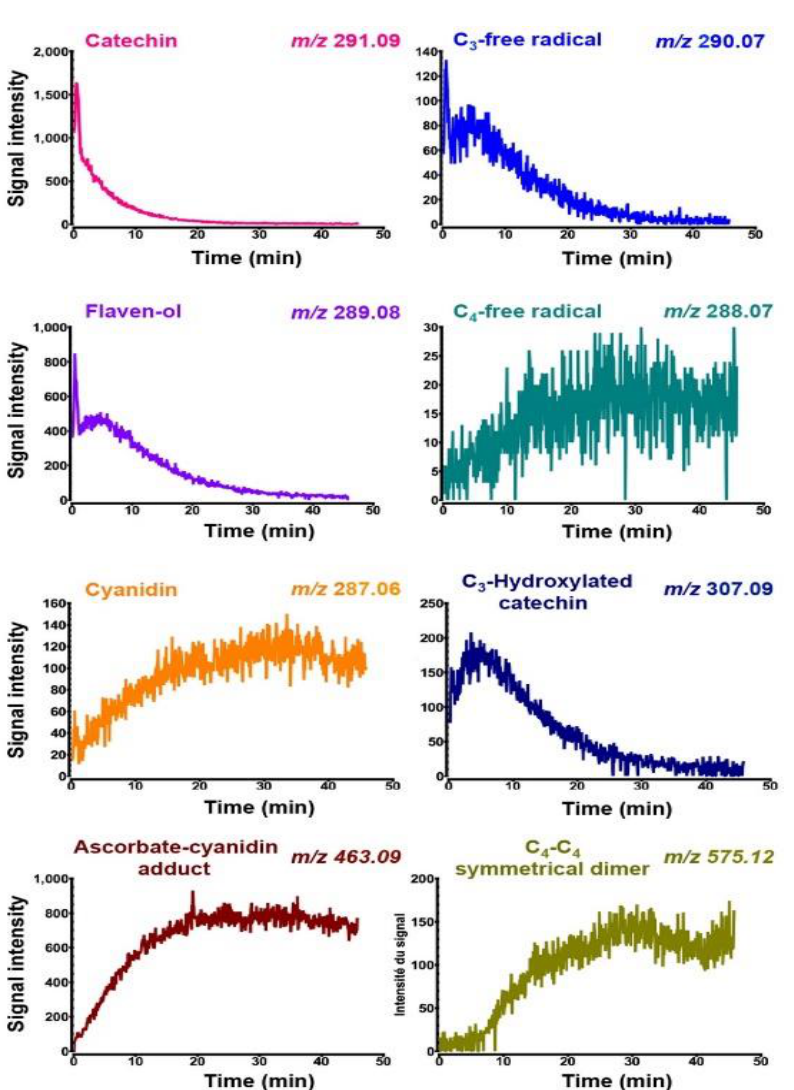
Figure 7. Time-course of (+)-catechin consumption and product formation by real-time mass spec-